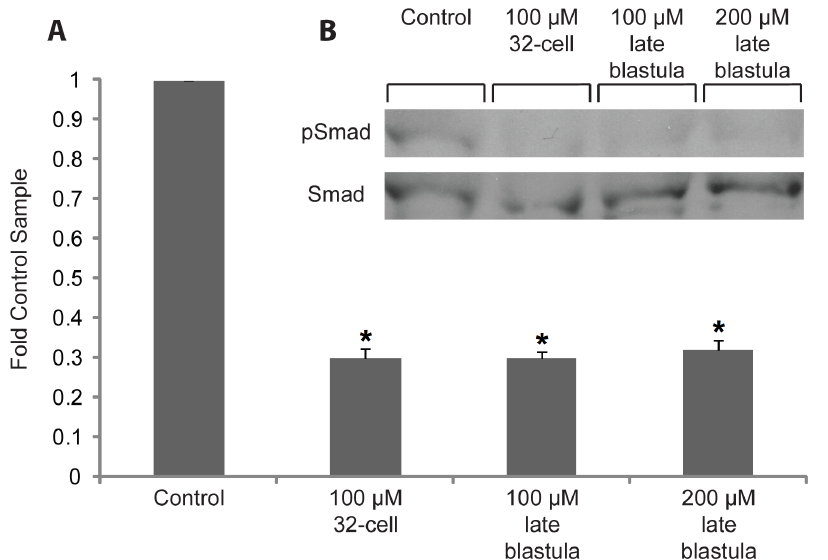
Figure 5. Dorsomorphin inhibits phosphorylation of Smad1/5. Bmp signalling activity was quantified by measuring phosphorylation of Smad 1/5 at the late gastrula stage. Embryos were exposed to 100 m M from 32-cell as well as 100 and 200 m M DM from late blastula. These were then frozen at the late gastrula stage and used for Western Blotting. A: Quantification of densitometry results obtained from 3 independent experiments (Mean 6 SE), normalised to total Smad and indicated as fold increase over the resting control condition. All 3 treatments were significantly different from the control as indicated by asterisks (P , 0.001), but no significant differences were observed between the treatments. B: Representative Western Blot of 3 independent experiments showing the levels of total Smad1/5/8 and phospho-Smad1/5 at late gastrula from the dose and stage specific treatments. These data demonstrate that all 3 treatments equally suppress phospho-Smad1/5 by late gastrula.